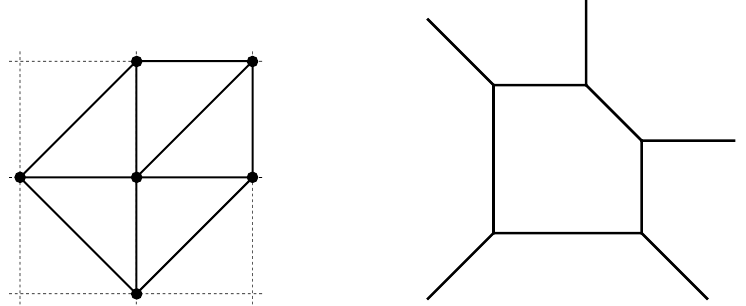
Figure 5: A triangulated toric diagram and its dual ( p , q )